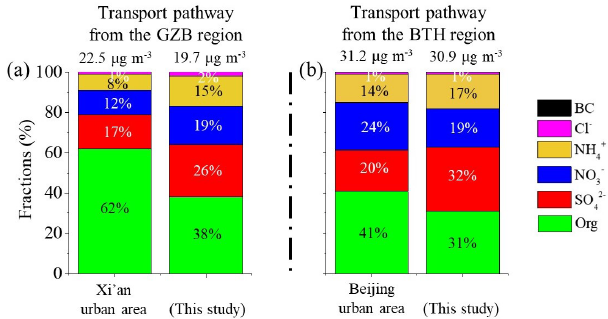
Figure 4. Chemical composition of the observation results which were long-term and right on the transport route of the BTH transport and the GZB transport, including the Beijing urban area (Xu et al., 2019), the Xi’an urban area (Duan et al., 2021), the BTH transport in this study (east transport) and the urban GZB transport in this study (west transport).